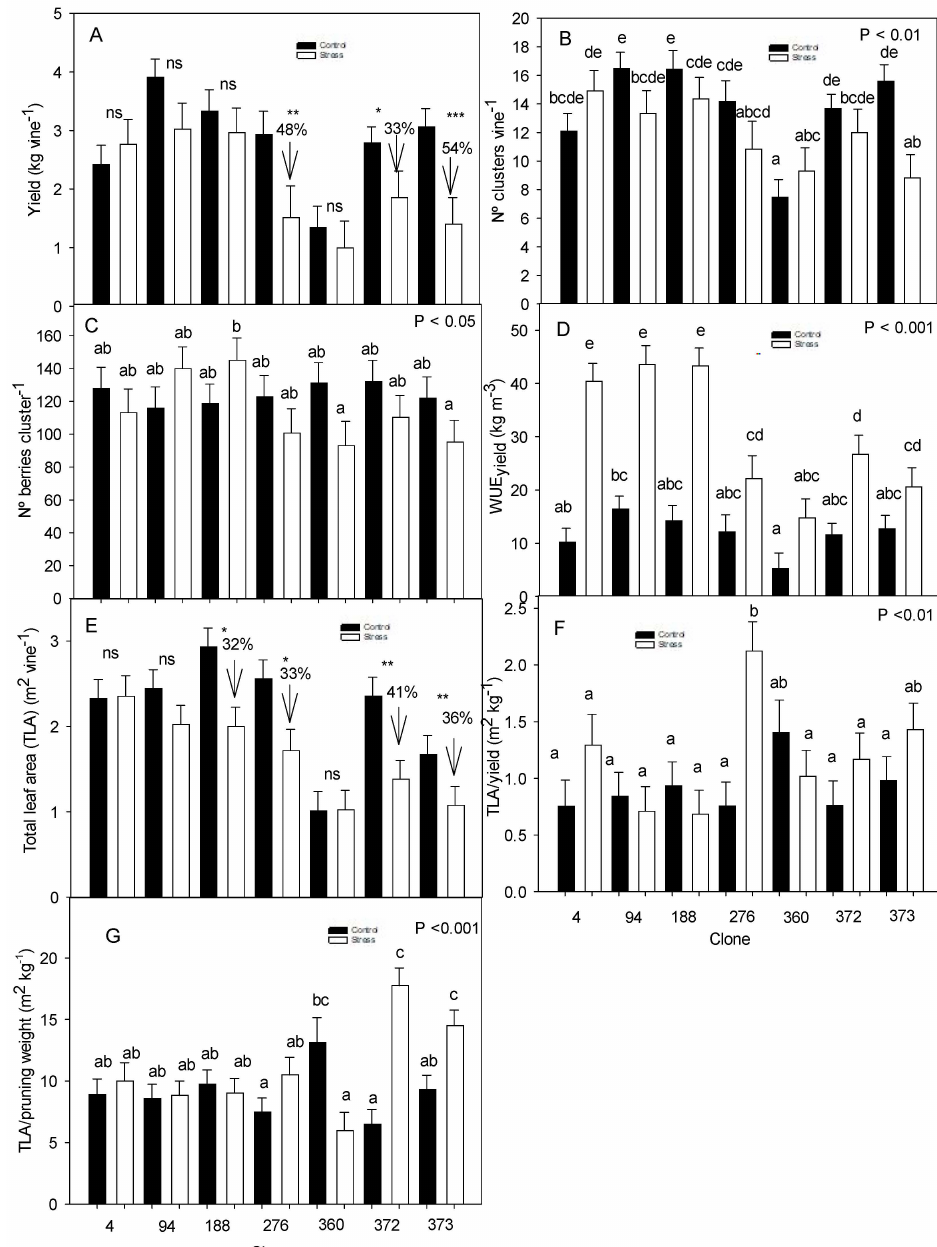
Figure 9. Significant interactive effects of clone and irrigation treatment in yield (yield, no. clusters per vine, no. berries per cluster and WUE yield ), vigour parameters (total leaf area), and sink-source ratios (TLA/yield, TLA/pruning weight). Values are the average of three years: 2018–2020. Arrows indicate the percentage of reduction with regards to their controls. Different letters indicate significant differences according to Duncan’s multiple range test at the 95% confidence level. In ( A ) and ( E ), we also did a unifactorial analysis (ANOVA) for each clone, looking for significant differences between control and stress treatment. ns, not significant. * p < 0.05; ** p < 0.01; ***, p < 0.001, according to Duncan’s multiple range test at the 95% confidence